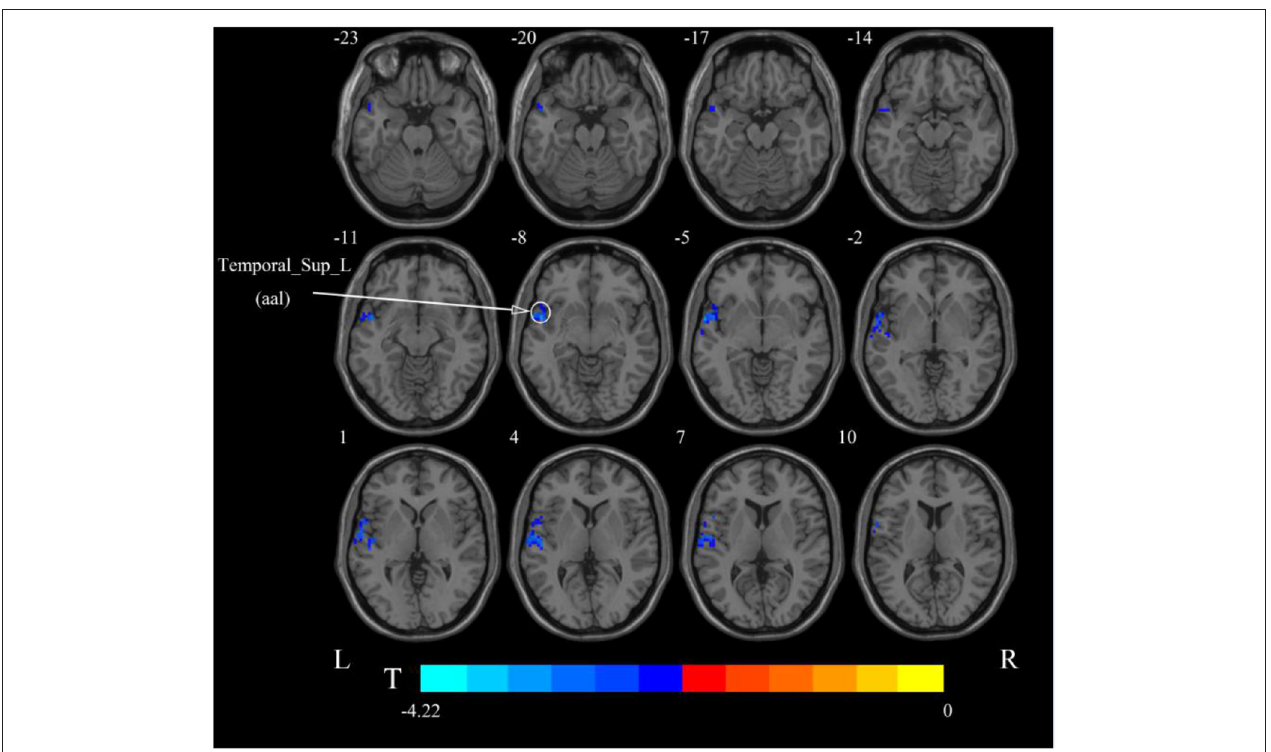
FIGURE 3 | Statistical maps showing ALFF change pre- and post-rTMS in the classical frequency band. Warm colors showing ALFF increased and cool colors showing ALFF decreased after rTMS p < 0.05.